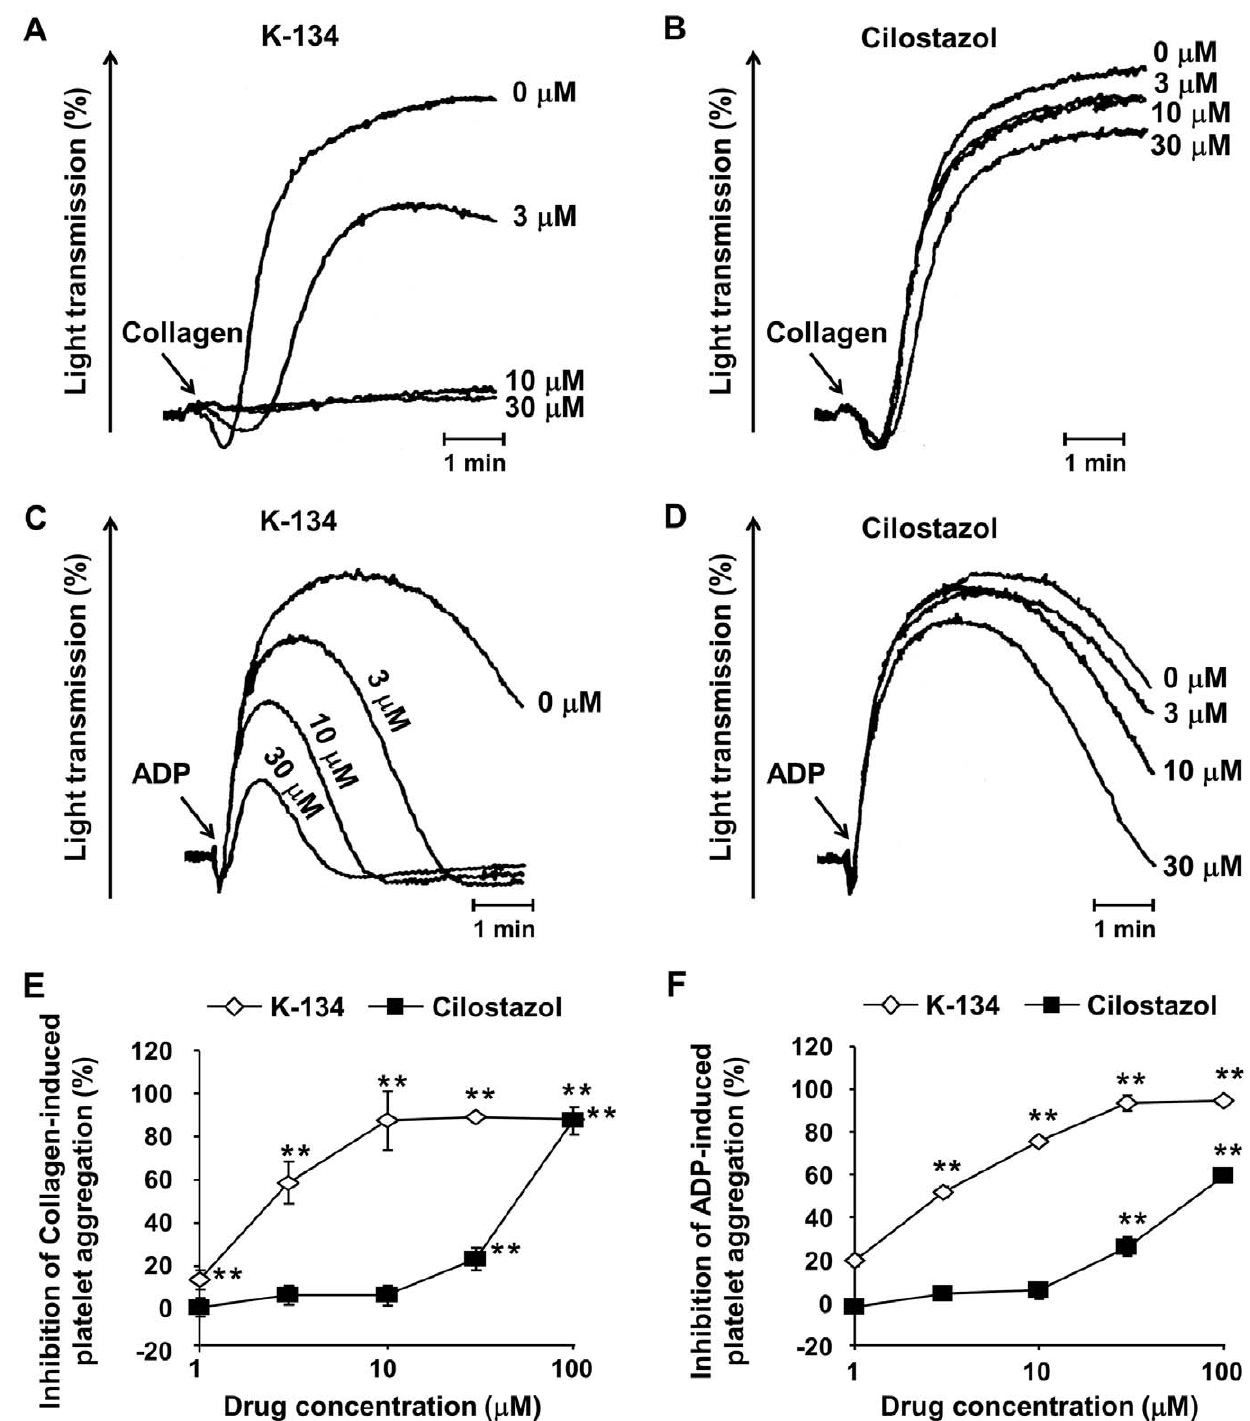
Figure 3. Inhibitory effects of PDE3 inhibitors on rat platelet aggregation invitro. ( A–D ) Representative aggregometer traces showing the effects of PDE3 inhibitors on rat platelet aggregation. Citrated PRP derived from rats was preincubated with K-134 ( A,C ) or cilostazol ( B,D ), and stimulated with collagen ( A,B ) or ADP ( C,D ). Inhibitory effects of agents on collagen ( E ) and ADP ( F ) were estimated by measuring the AUC during the 5 min after stimulation. Values are means 6 SEM (* P , 0.05, ** P , 0.01, two-tailed Dunnett’s test, n =5). doi:10.1371/journal.pone.0046432.g003 after a single oral administration to non-fasting male SD rats at compared with that of cilostazol [11]. Therefore, development of doses of 10 mg/kg and 30 mg/kg were low (2.38 and 14.09 m M ? h, an extended release oral dosage form of K-134 may lead to greater respectively) because of its short elimination half-life (T 1/2 ) long-term pharmacological effects in vivo . In the arteriovenous